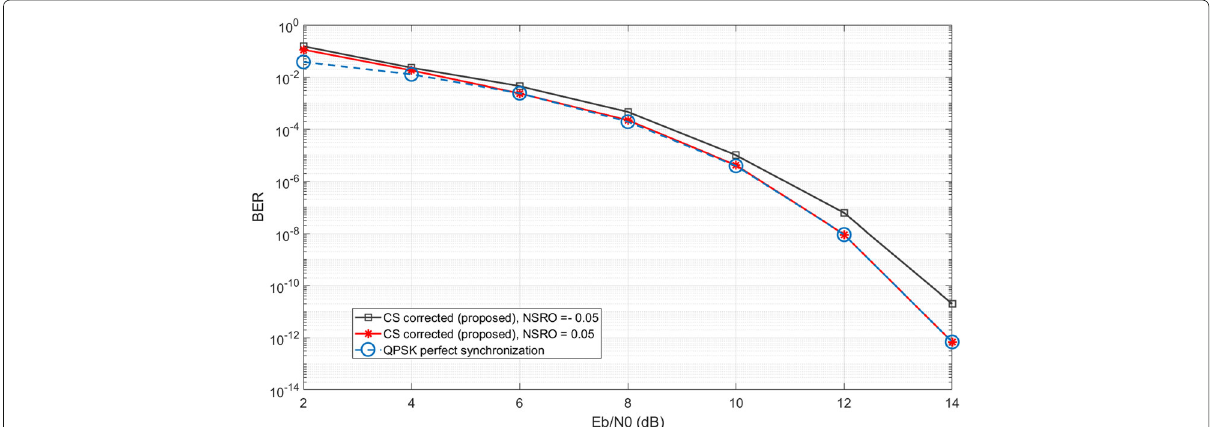
Fig. 11 BER performance for η = − 0.05 and η = 0.05, N = 300, modulation type =